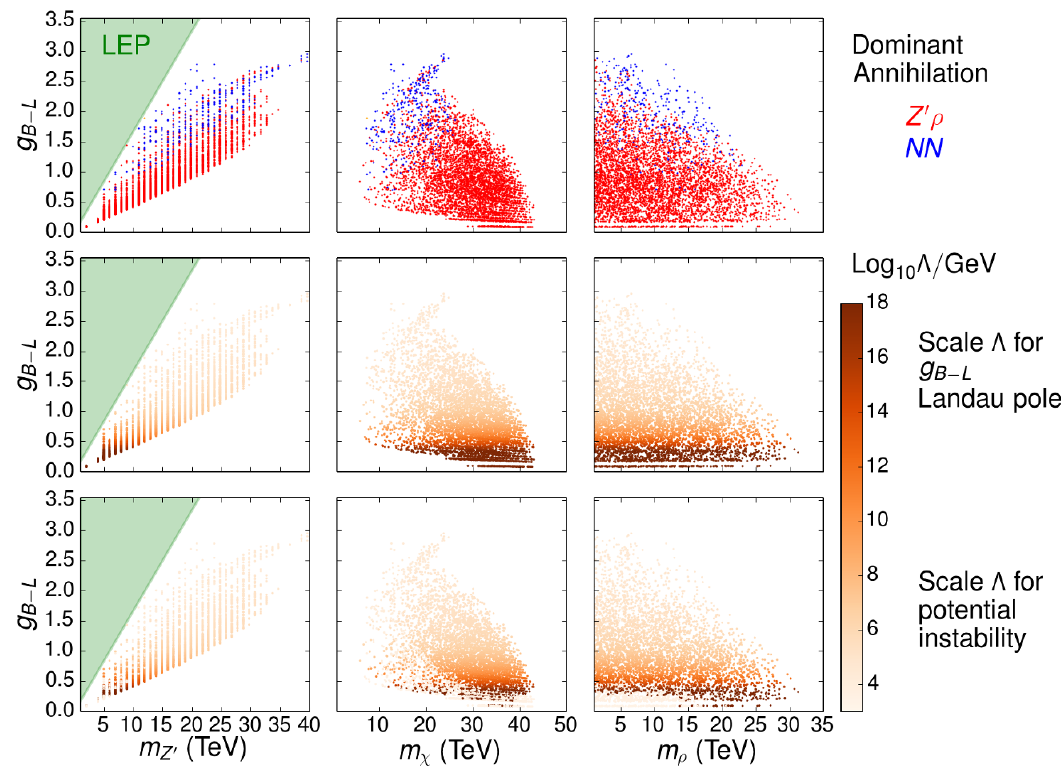
Figure 7 . High mass region of the model. All points correspond to (cid:10) (cid:31) h 2 = 0 : 12, resonant regions (0 : 4 < m (cid:31) =m Z 0 ; m (cid:31) =m (cid:26) < 0 : 6) have been removed and perturbative unitarity on the couplings and masses has been imposed (see eqs. (5.2){(5.3)). The upper panel shows the parameter space categorized by the dominant annihilation channel in the contemporary Universe. The middle panel shows the result of the parameter scan, with color coding depicting the scale at which a Landau pole appears for g B (cid:0) L . The lower panel shows the result of the parameter scan, with color coding depicting the scale at which the scalar potential becomes unstable. It is clear that m Z 0 ; m (cid:31) ; m (cid:26) . 40 TeV, and that if one requires that a Landau pole appears above (cid:3) = 100 TeV then g B (cid:0) L .